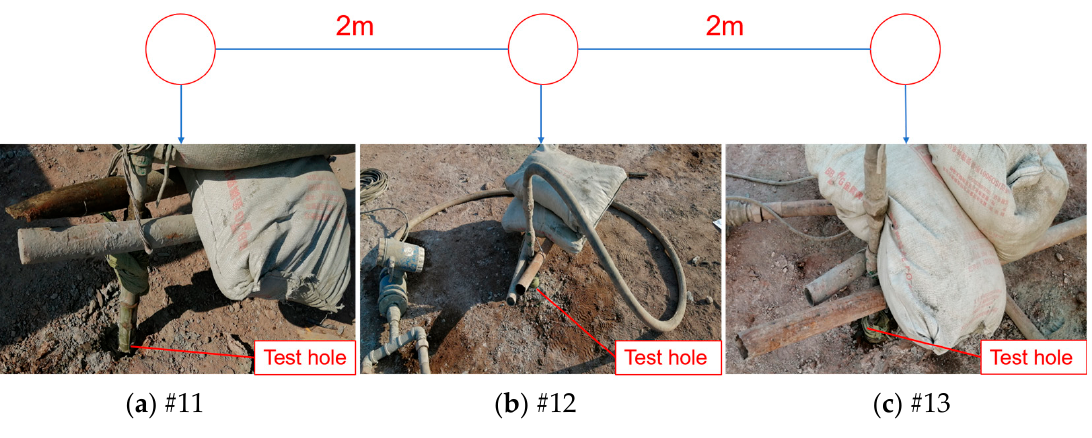
Figure 8. Grouting hole layout